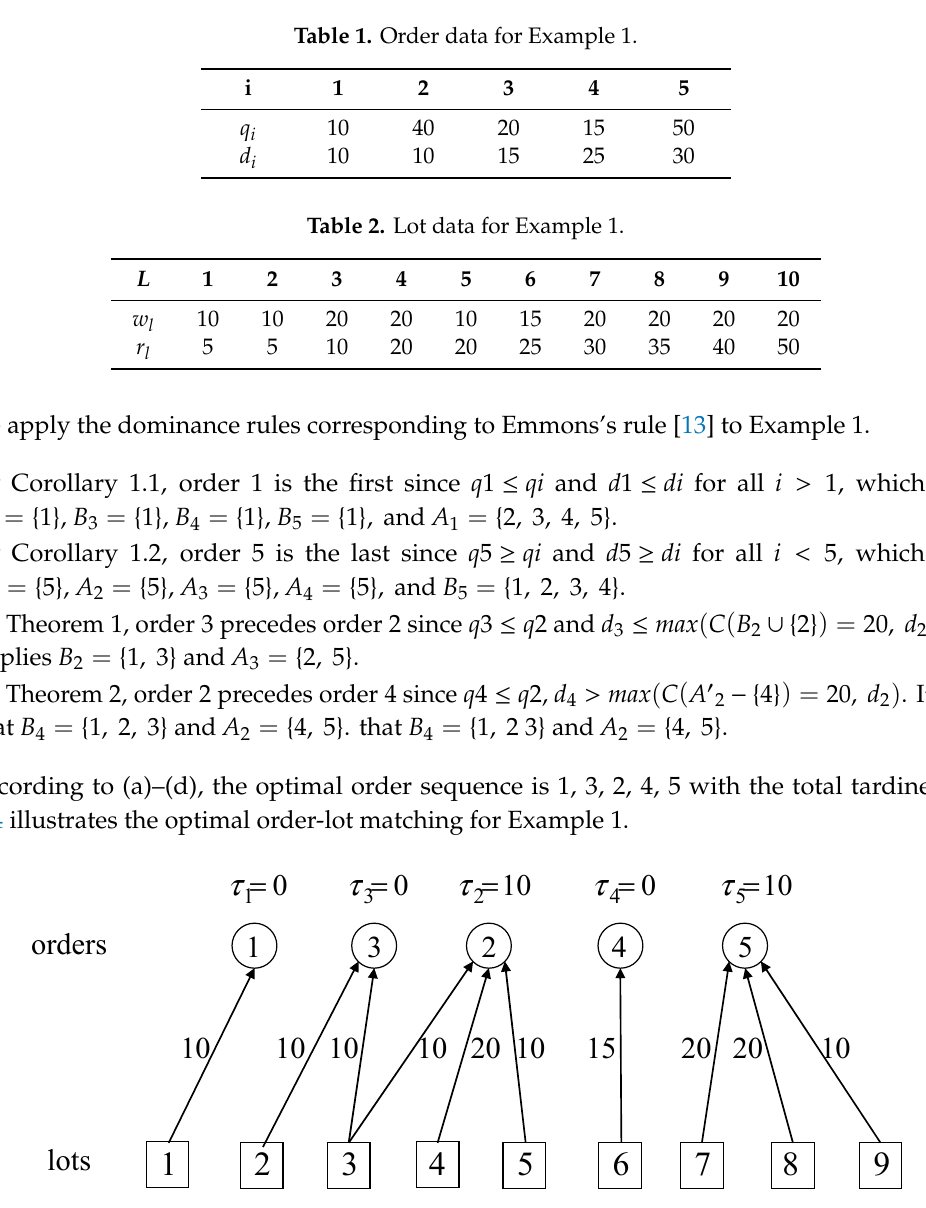
Table 1. Order data for Example 1.